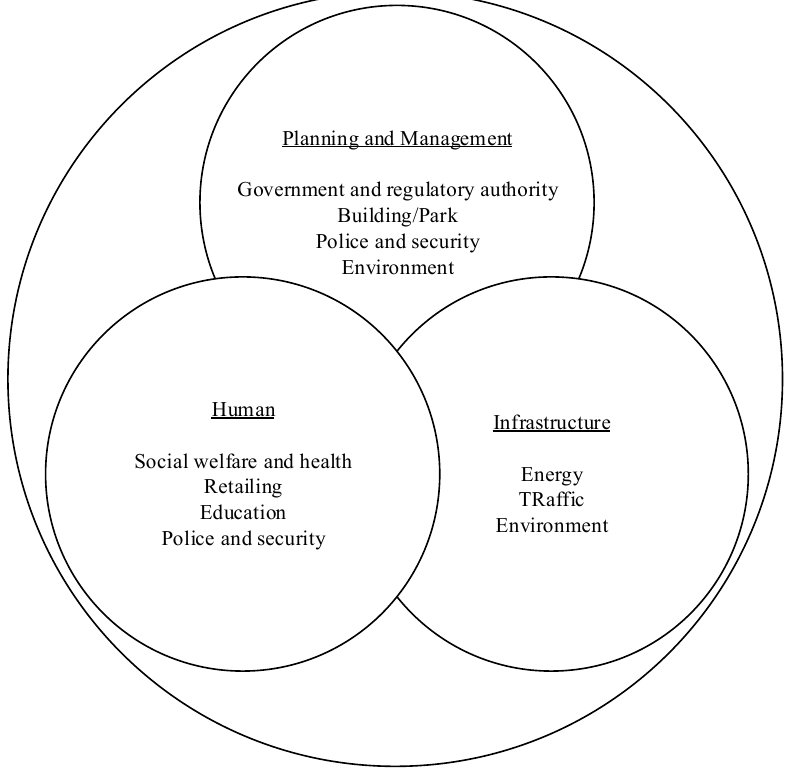
Figure 1. A schematic diagram of smart city.